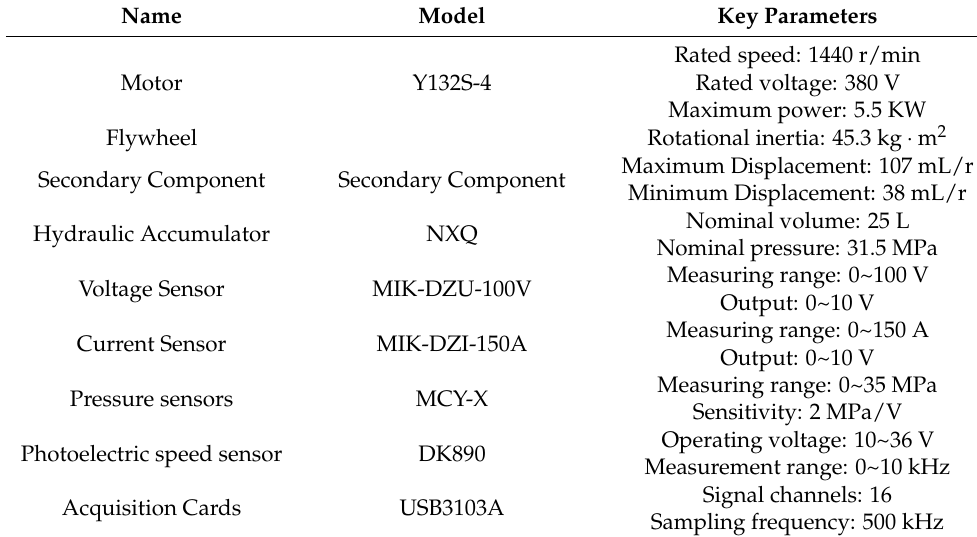
Figure 5. The HRBS test bench: 1 — motor; 2 — electromagnetic clutch; 3 — magnetic powder brake; 4 — flywheel; 5 — revolution speed transducer; 6 — commutator; 7 — electromagnetic clutch No. 2; 8 — hydraulic pump and motor; 9 — tank; 10 — relief valve; 11 — hydraulic pressure sensor; 12 — hydraulic accumulator; 13 — hub motor; 14 — proportional amplifier; 15 — oil discharge valve. Table 1. Main component parameters of the kinetic energy simulation part.